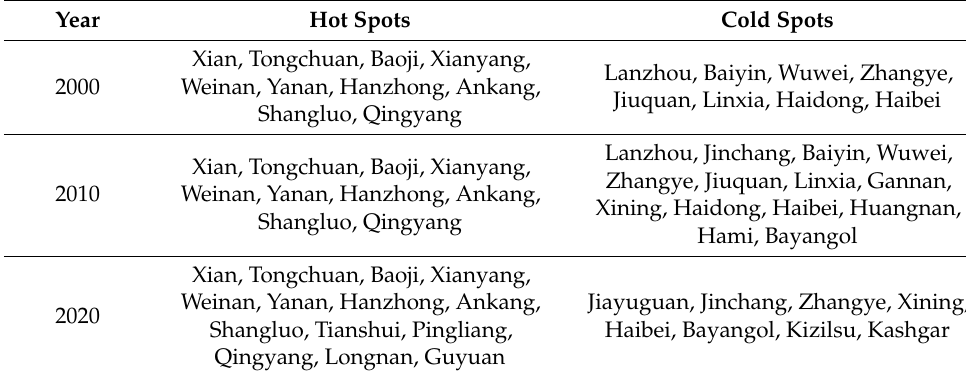
Table 4. Cold and hot spot results of coordinated